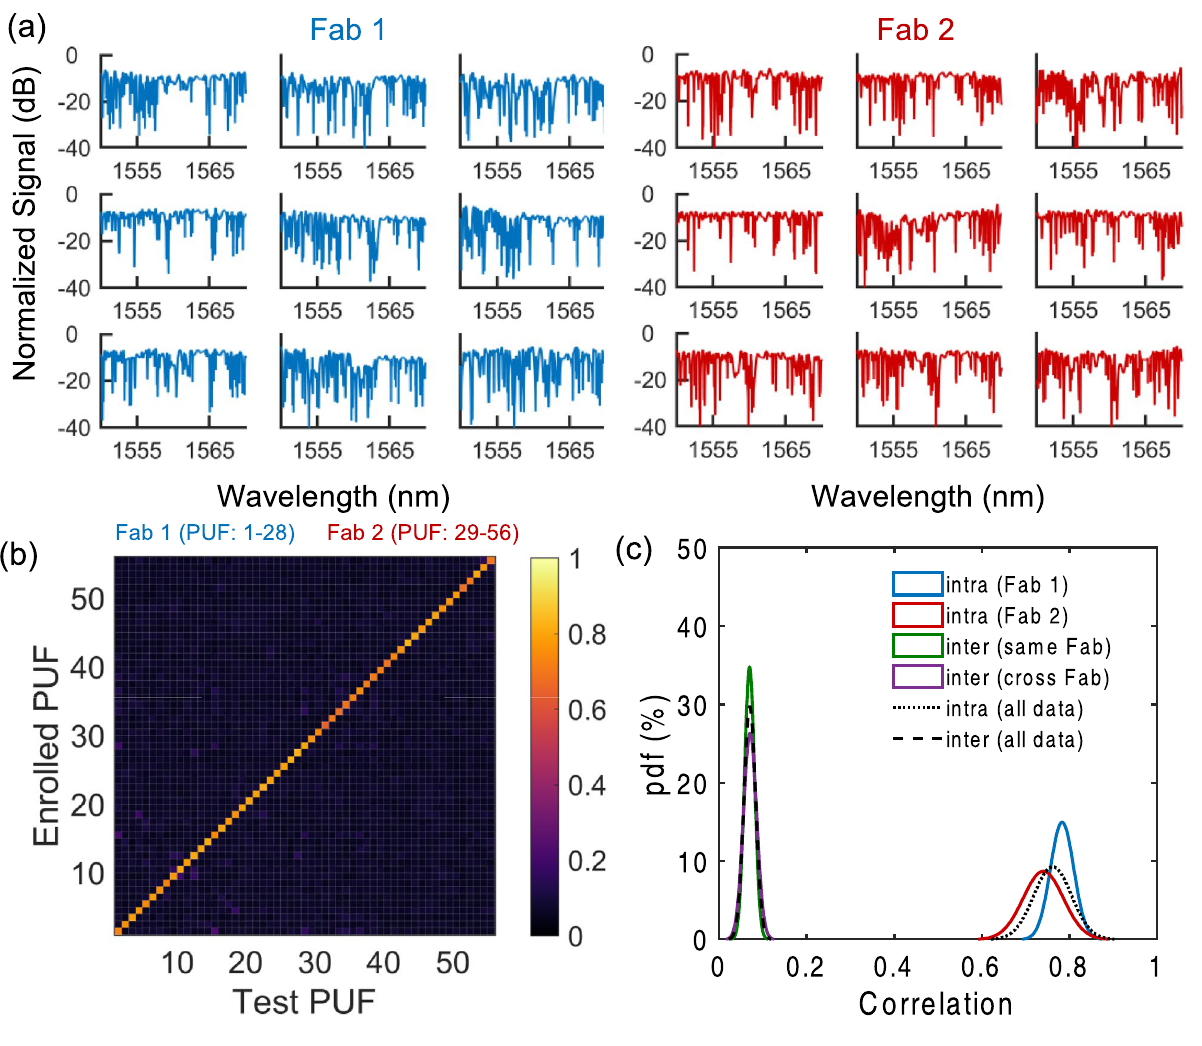
Figure 4. Cross-fab analysis: ( a ) QCI PUF spectra for a selected subset of 9 out of 28 PUFs from each Fab; ( b ) summary of cross-correlation based authentication results (k = 3) for all 56 PUFs; and ( c ) intra-chip and inter- chip distributions obtained when comparing PUF keys across or within each